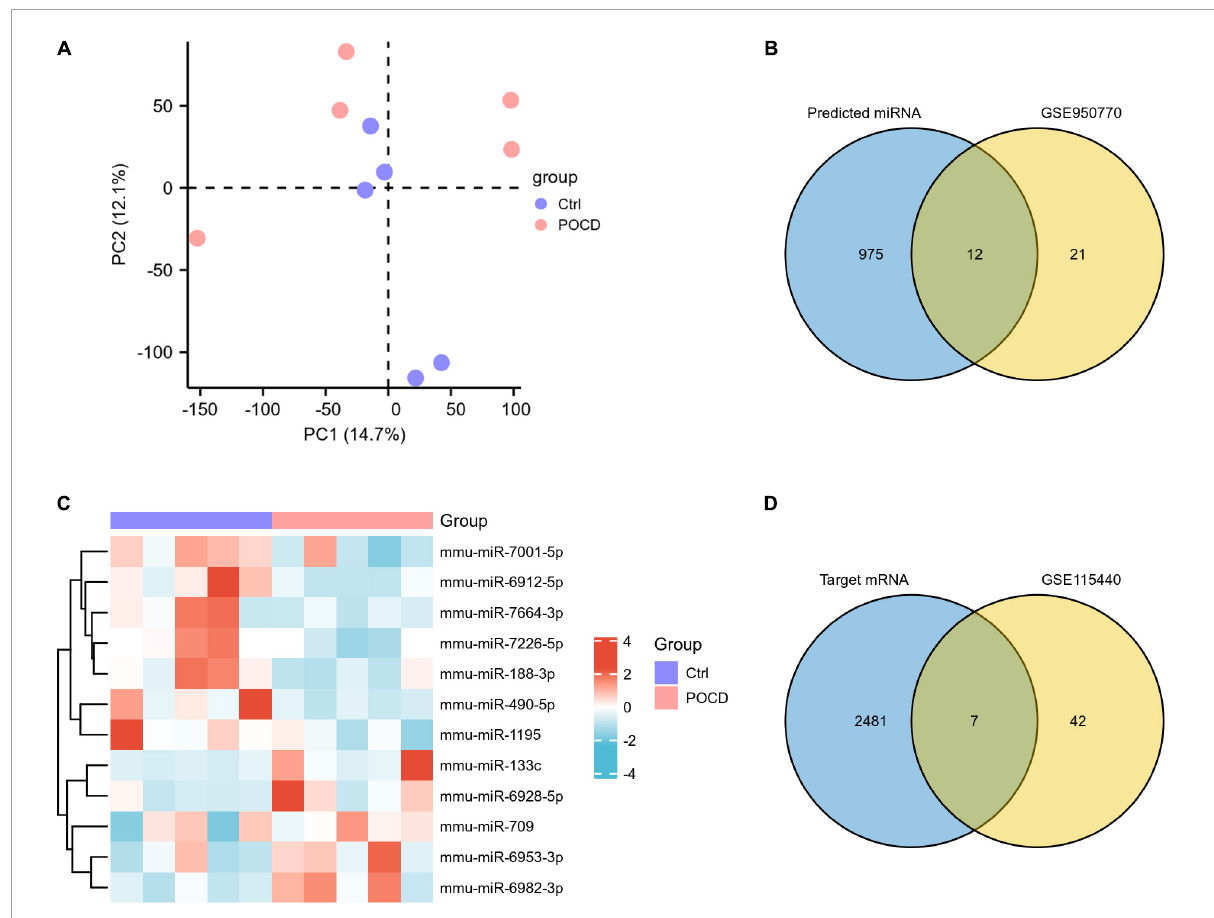
FIGURE4 Characteristics of differentially expressed miRNAs (DEmiRNAs) in postoperative cognitive dysfunction (POCD). (A) Principal component analysis (PCA) of miRNA expression between POCD and control groups. (B) The 12 DEmiRNAs were obtained by overlapping the 987 target miRNAs binding to the three DEcircRNAs and the 33 DEmiRNAs identified in GSE95070. (C) The heatmap of the 12 overlapped DEmiRNAs. (D) The seven DEmRNAs were obtained by overlapping the 2,488 target mRNAs binding to the 12 DEmiRNAs and the 49 DEmRNAs identified in